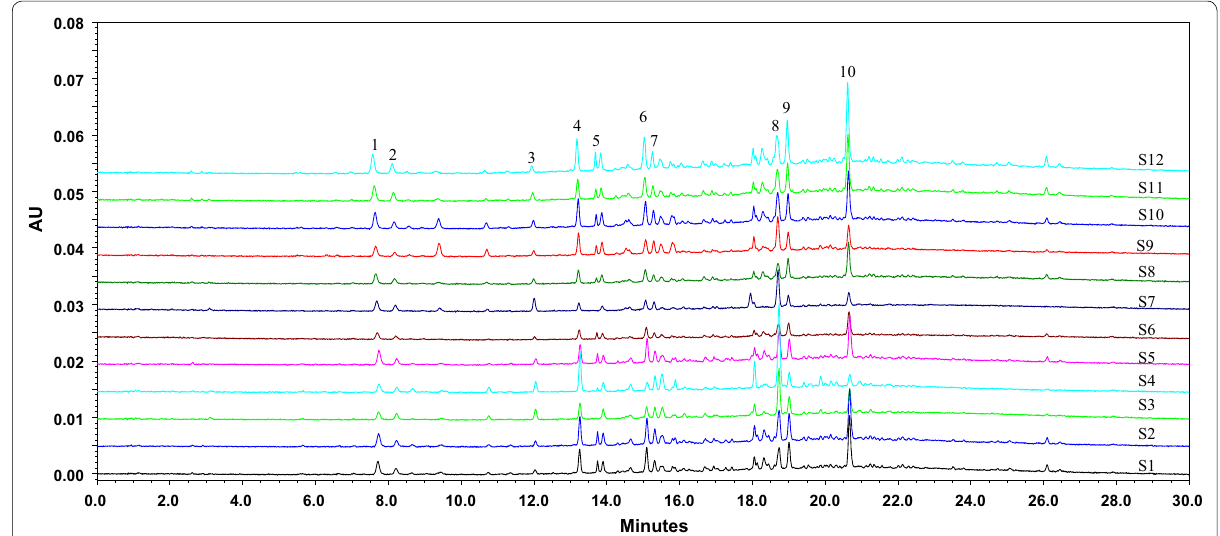
Fig. 3 UPLC fingerprints of 12 batches of Resina Draconis at 280 nm. S1 – S12 represents Resina Draconis samples numbered from 1 to 12